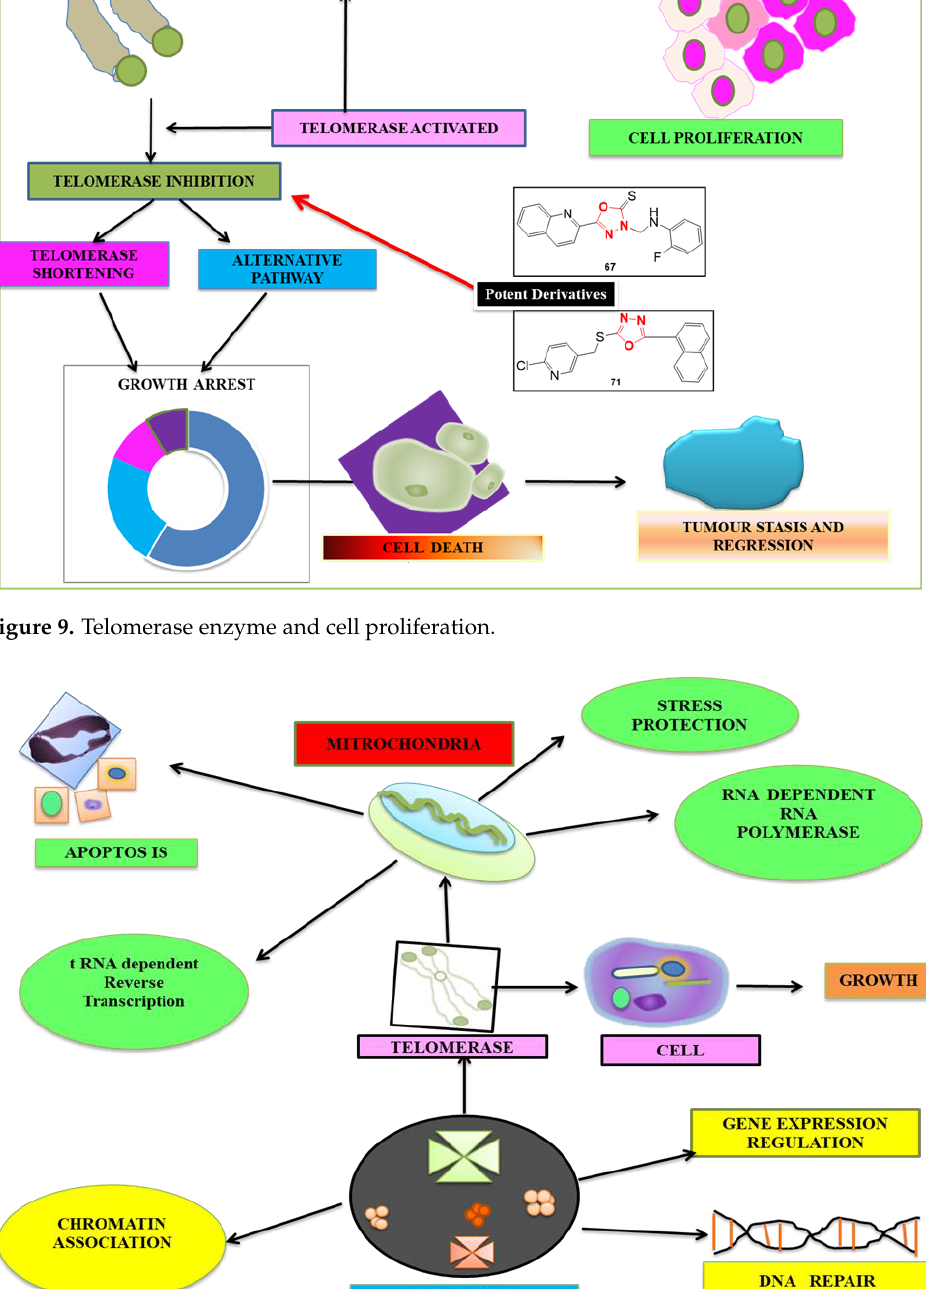
Figure 10. Various functions of the telomerase enzyme .